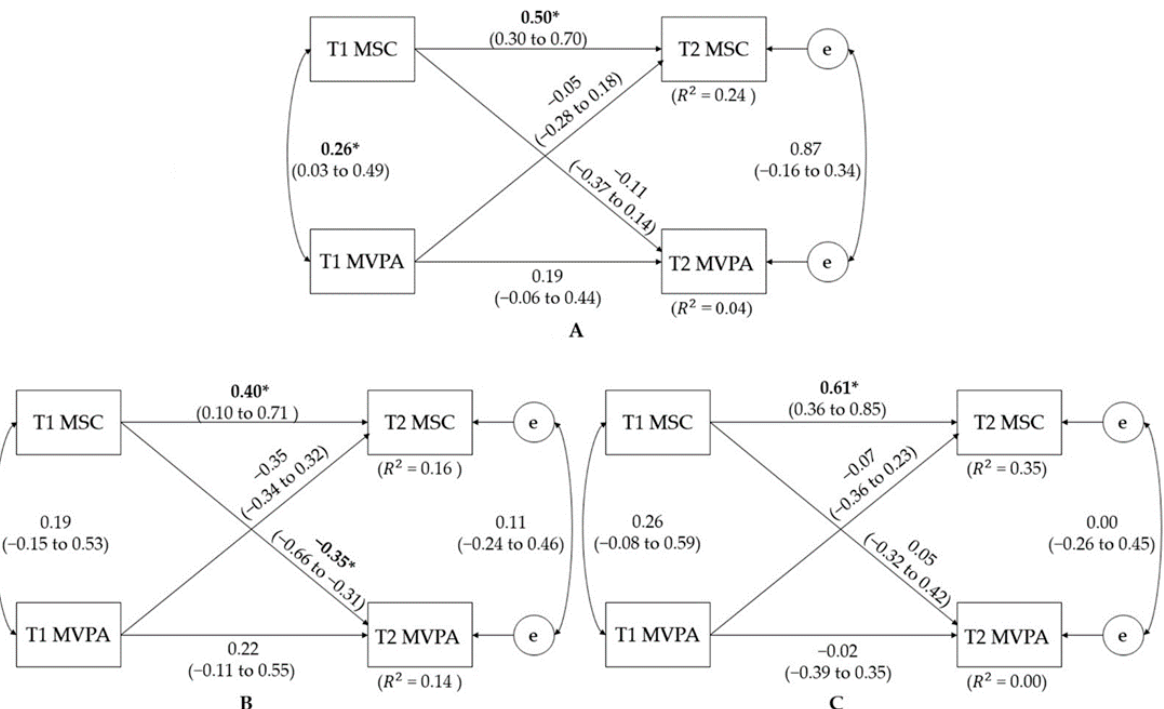
Figure 1. Cross-lagged model of the bidirectional relationships between MSC and total MVPA time before and after the 8-week study period for ( A ) total, ( B ) girls, and ( C ) boys. T1—baseline time; T2—follow-up time; e—error; R2 = coefficients of determination; MSC—motor skill competence; MVPA—moderate-to-vigorous physical activity. Path coefficients are standardized with 95% confidence intervals. * denotes a statistically significant path coefficient with p < 0.05.